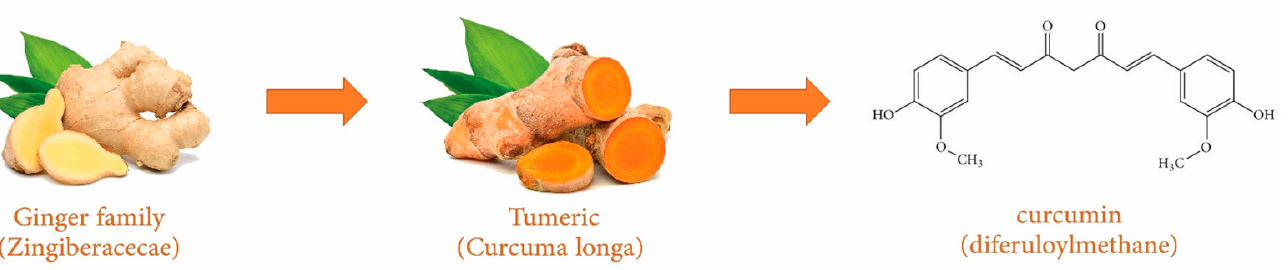
Figure 1. Chemical structure of curcumin.